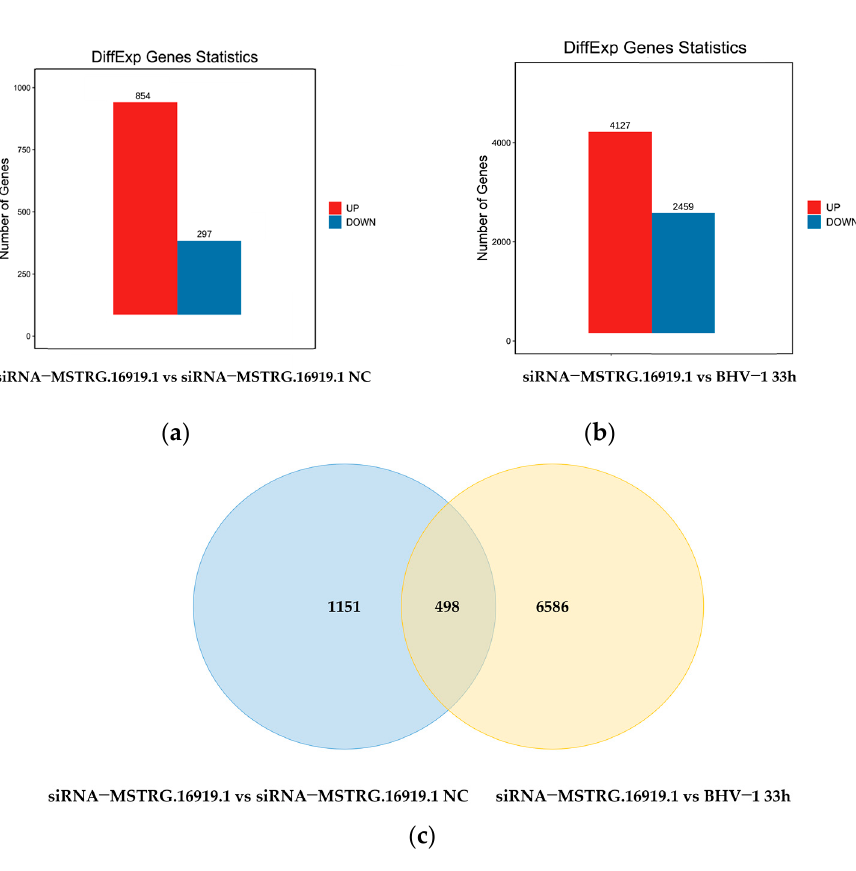
Figure 2. Statistical diagram of differential genes. ( a ) Gene statistics of the difference between siRNA − MSTRG.16919.1 and siRNA − MSTRG.16919.1 NC ; ( b ) siRNA − MSTRG.16919. 1 and BHV − 1 33 h differential genes statistics; ( c ) repeat gene screening for groups a and b.